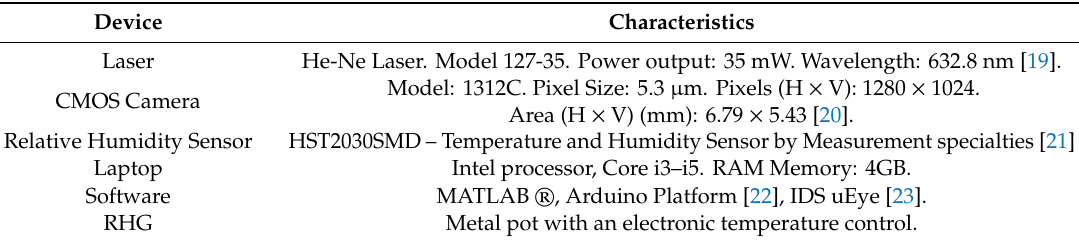
Table 1 . Summary of the main setup parameters.